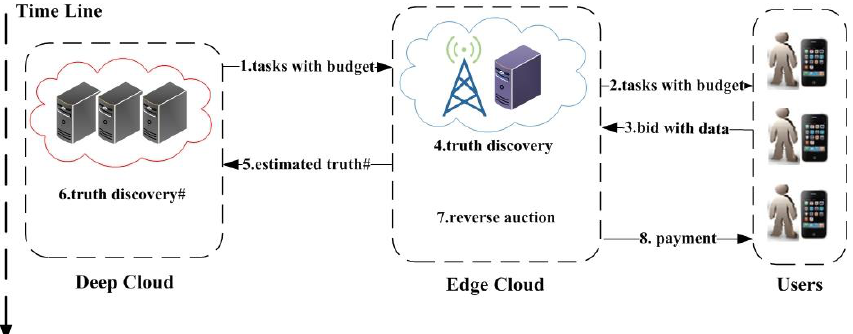
Figure 1. Edge-assisted large-scale mobile crowdsensing (# represents the optional operation).